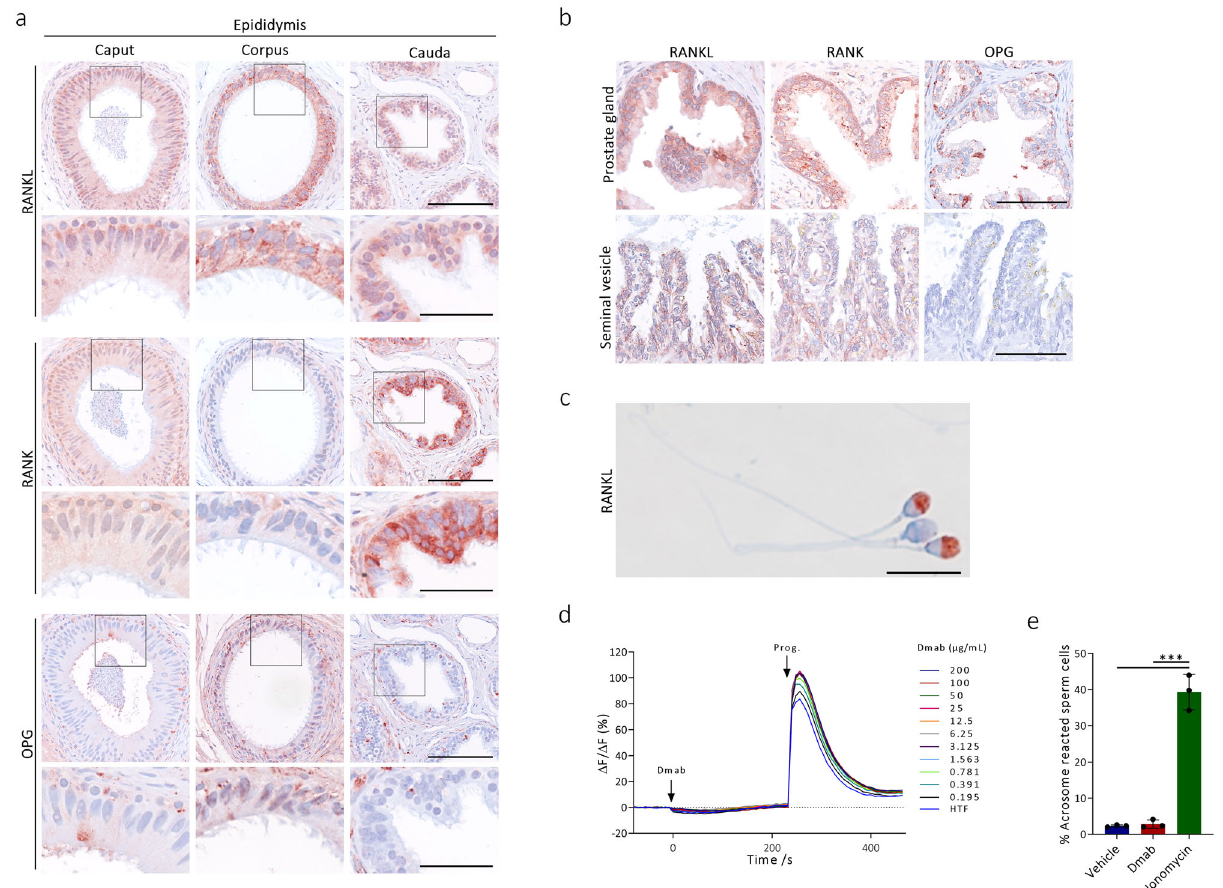
Fig. 4 Expression of RANKL, RANK, and OPG in male reproductive tract and effects of denosumab on human spermatozoa. a Expression of RANKL (sc- 9073), RANK (sc-9073), and OPG (sc-8468) in human caput, corpus, and cauda epididymis. Counterstaining with Mayer ’ s hematoxylin. Scale bars correspond to 125 µ m for low magni fi cation (upper panels) and 50 µ m for high magni fi cation (lower panels). Black inserts mark high magni fi cation areas. b Expression of RANKL (sc-9073), RANK (sc-9073), and OPG (sc-8468) in human prostate gland and seminal vesicle. Counterstaining with Mayer ’ s hematoxylin. Scale bars correspond to 100 µ m. c Immunostaining of RANKL (sc-9073) in human spermatozoa. Counterstaining with Mayer ’ s hematoxylin. Scale bar corresponds to 10 µ m. d Intracellular Ca 2 + signals induced by Denosumab in concentrations from 200 µ g/mL to 0.195 µ g/mL (indicated by different colors). Δ F/F0 (%) indicates the percentage change in fl uorescence that translates into cytoplasmic calcium changes. Progesterone (100 nM) was used afterwards to test for an augmented effect, while human tubular fl uid (HTF) was used as a negative control (repeated twice in three donors). e Acrosome reacted spermatozoa (% of number of spermatozoa) from healthy donors after treatment with Denosumab (6 µ g/mL, red), the positive control ionomycin (10 µ M, green), or vehicle treatment (HTF with 0.2% DMSO, blue), ( p < 0.0001, p < 0.0001). Data presented as mean (D) or mean ± SEM ( e ) with n = 3 ( d , e ). Statistical test: one-way analysis of variance (ANOVA) with Dunnett ’ s test to adjust for multiple comparisons ( e )